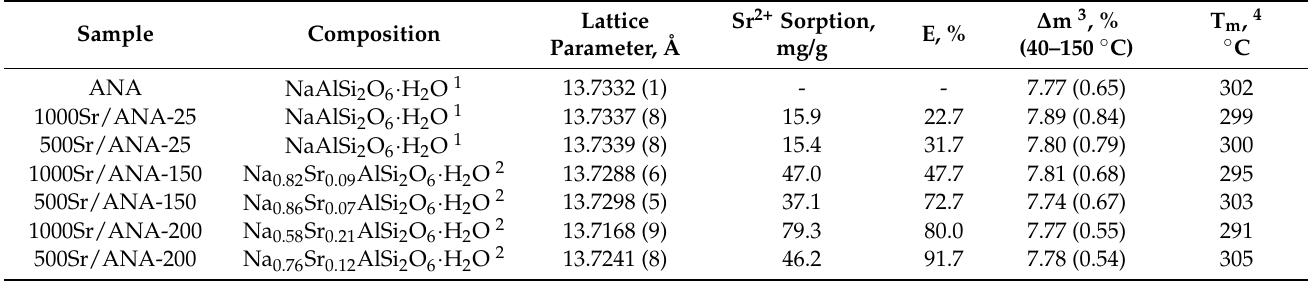
Table 2. Composition, lattice parameters for Na,Sr-ANA phases, Sr 2+ sorption and efficacy of Sr 2+ extraction from solutions, TG data for the